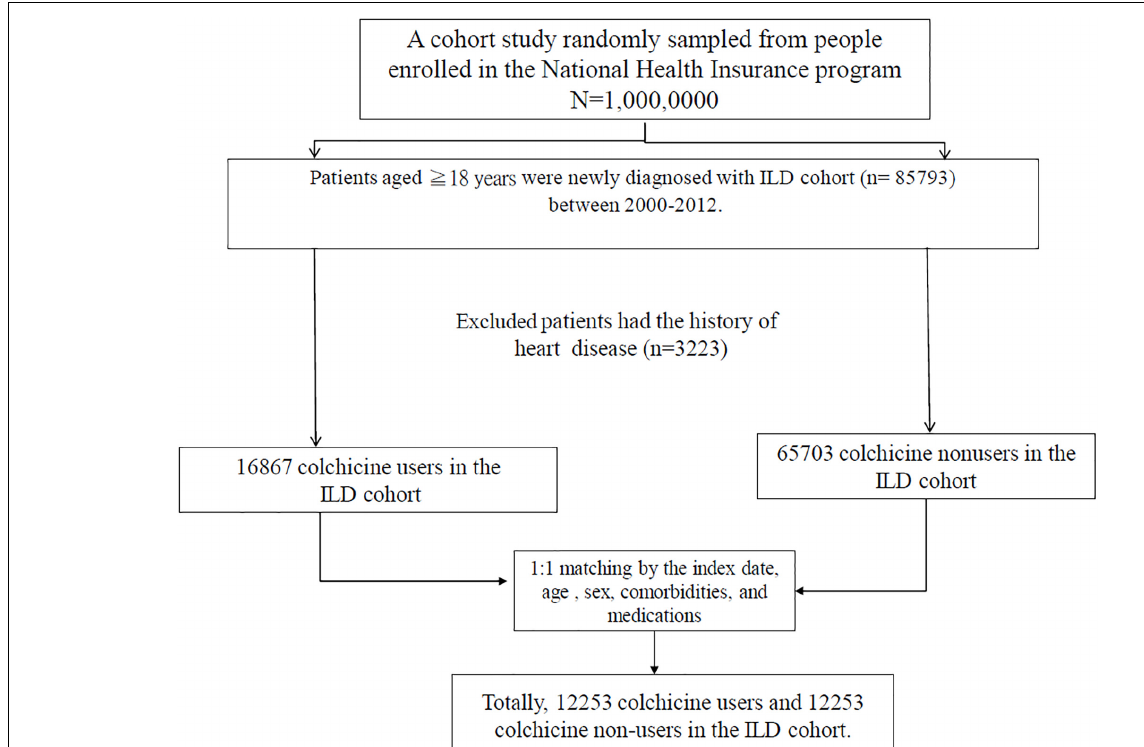
FIGURE 1 | Flow chart.